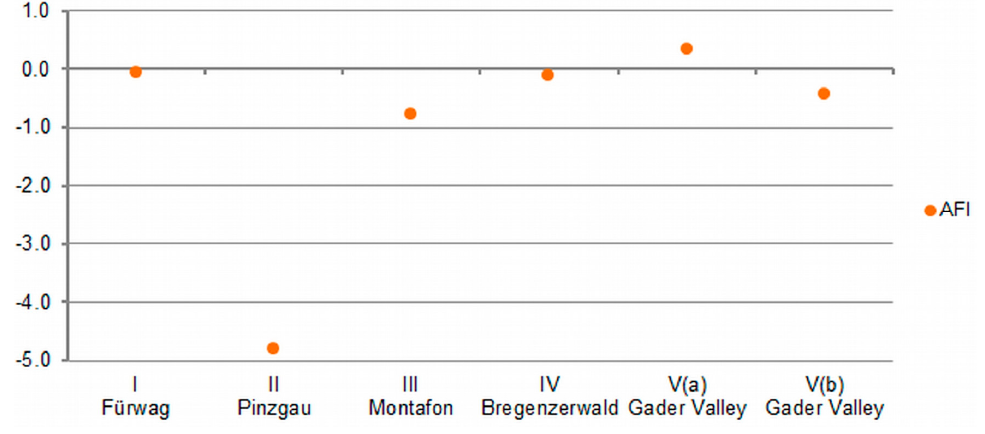
Figure 9. Global values of Area-Fit-Index (AFI) for the selected study sites.